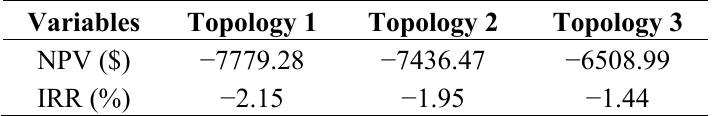
Table 9. Net present value (NPV) and internal rate of return (IRR) for the topologies analyzed.